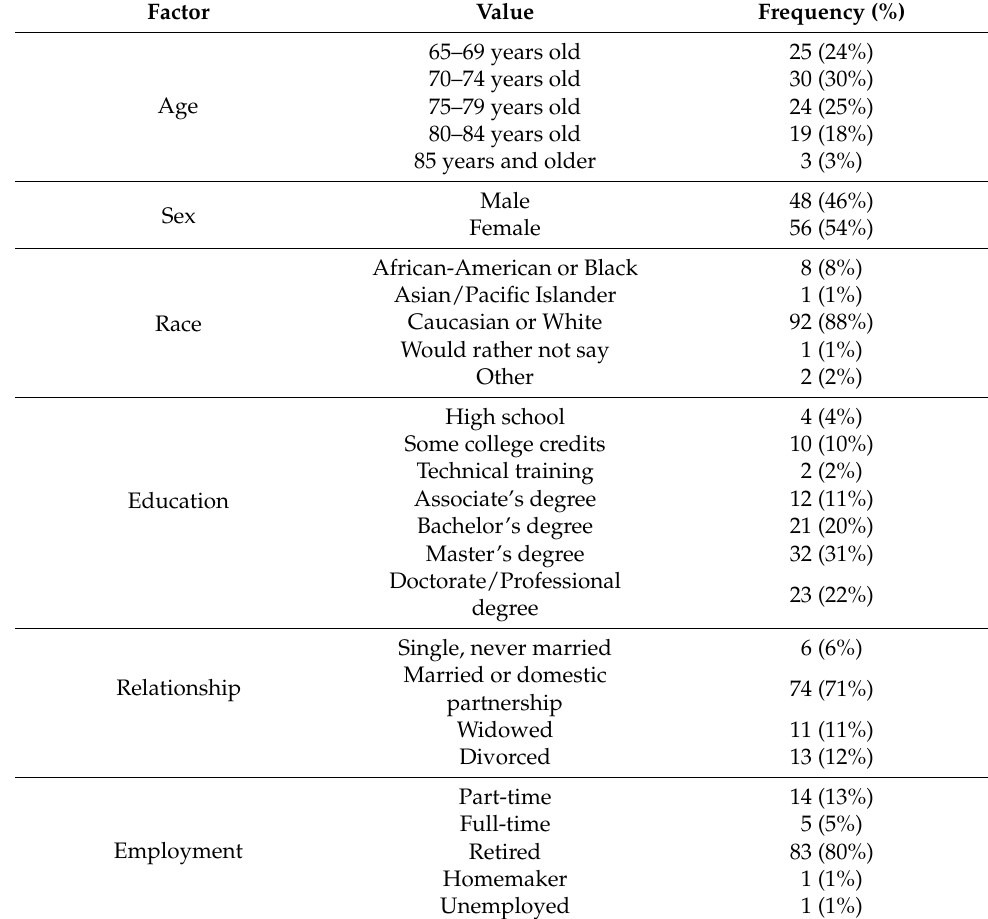
Table 1. Demographics of Older Drivers ( n = 104).